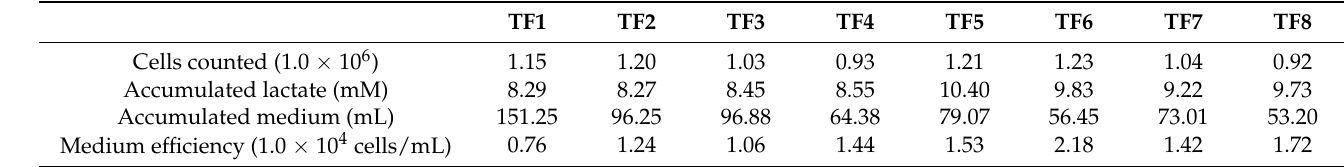
Table 5. Cell expansion results from the first controller experiment. Number of cells counted, total amount of accumulated lactate produced (mM), total amount of medium supplied (mL) and the overall medium efficiency (cells/mL). TF1